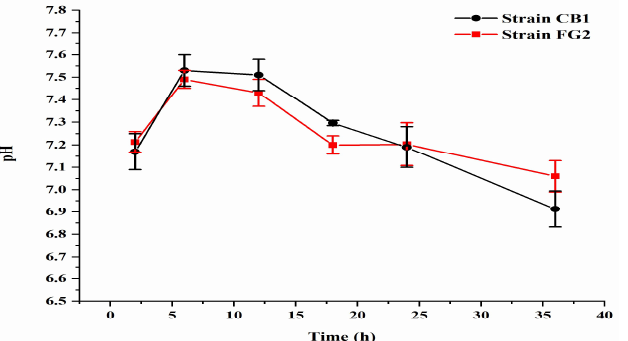
Figure 5. The growth of strain FG2 and strain CB1 and pH change in M1 medium. Bacterial growth was monitored for 36 h at different time intervals (2 h, 4 h, 6 h, 12 h, 18 h, 24 h, and 36 h). Data is presented as mean and standard error of three independent observations.